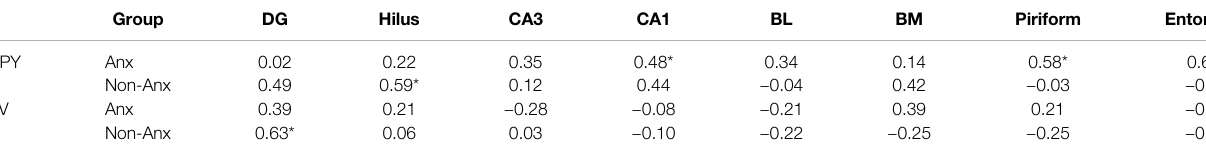
TABLE 3 | Correlation between NPY and PV density and SRS frequency.